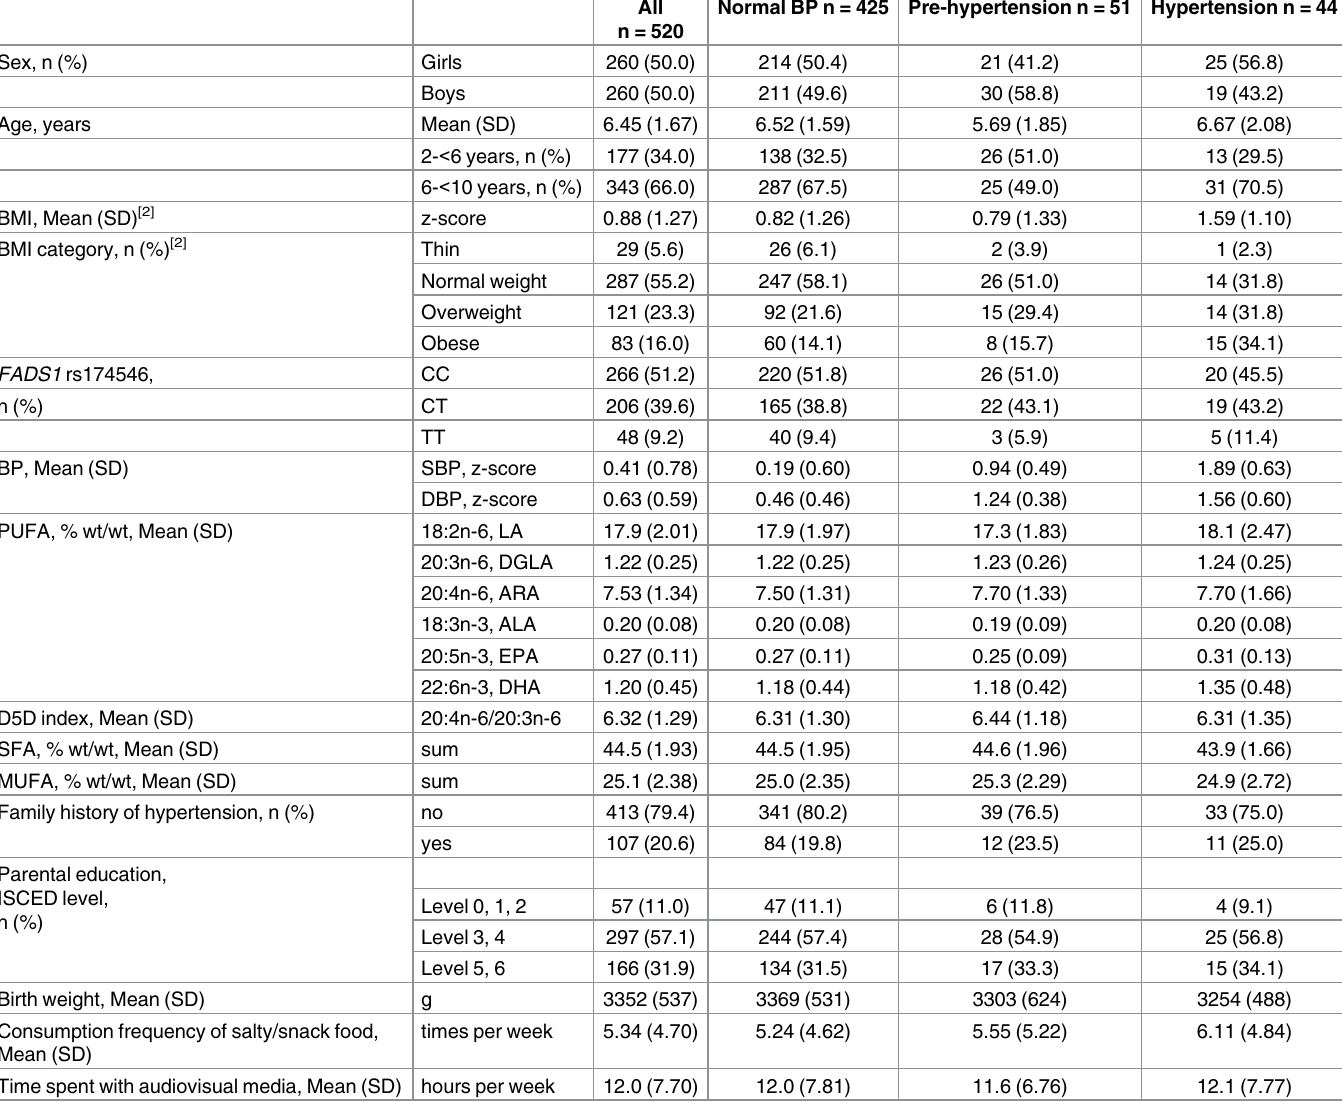
Table 1. Baseline characteristics of the study population by blood pressurecategory [1]